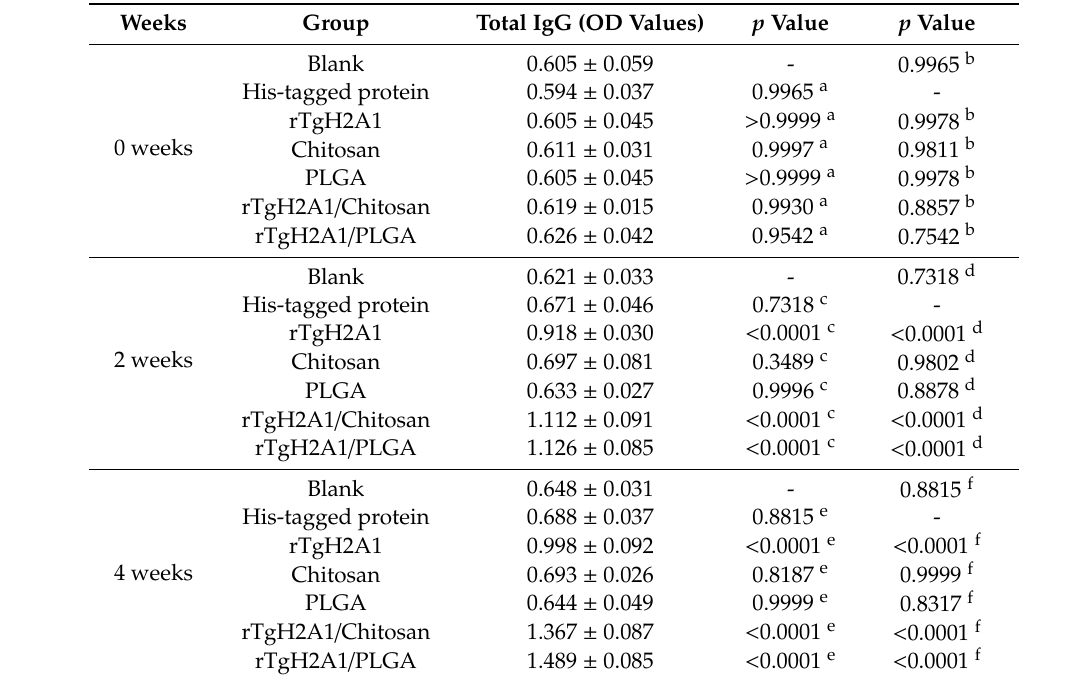
Table 1. Determination of total IgG antibodies in the sera from mice immunized with PBS, his-tagged protein, rTgH2A1, PLGA, chitosan, rTgH2A1 / PLGA, and rTgH2A1 / chitosan on weeks 0, 2, and 4. Results were evaluated using one-way ANOVA analysis followed by Dunnett’s test and shown as the mean of the OD450 ± standard